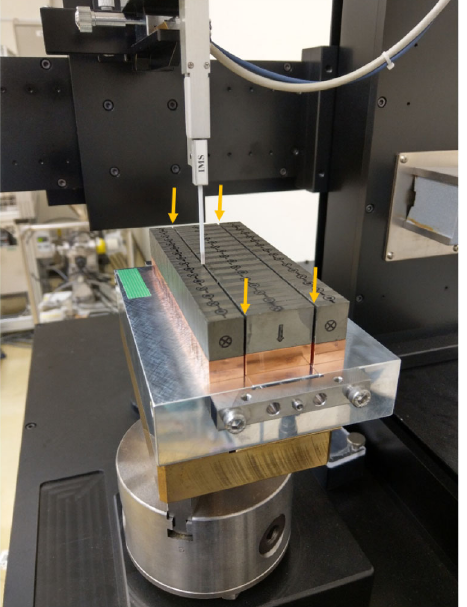
FIG. 9. Photograph of one of the two prototype magnetic